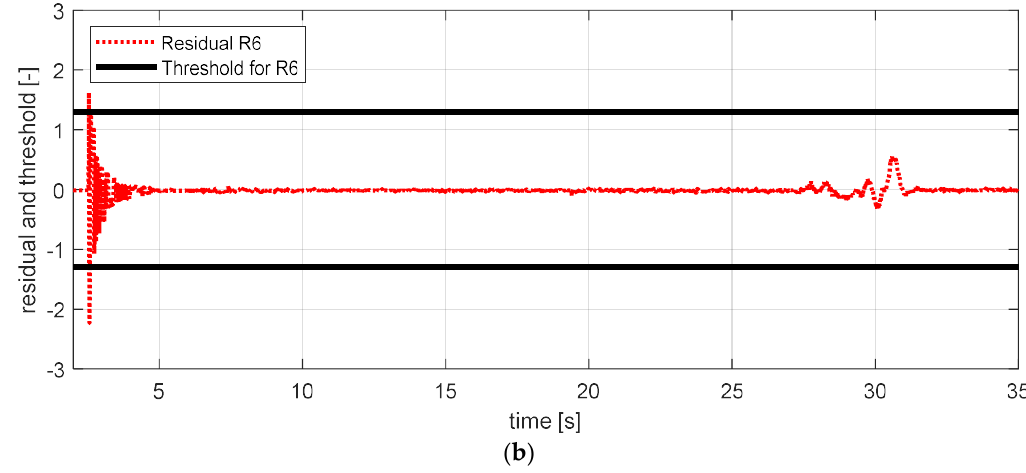
Figure 27. FDI simulation result for a steering wheel angle sensor (normal). ( a ) Residual 5 and threshold; ( b ) residual 6 and threshold.